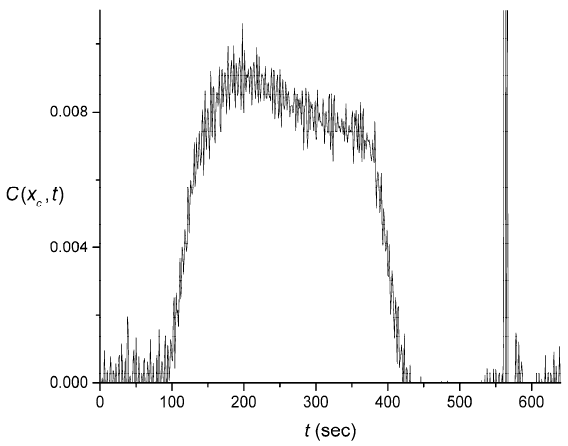
Figure 6. Example of a rectangular input pulse (cid:1829)((cid:1876) (cid:3030) ,(cid:1872)) generated from one of the measured output signals, (cid:1845)((cid:1872)) , shown in blue color in Figure 1A, without any signal smoothing/averaging. The erratic variation at ~565 s is likely an effect of a bubble in the input channel.